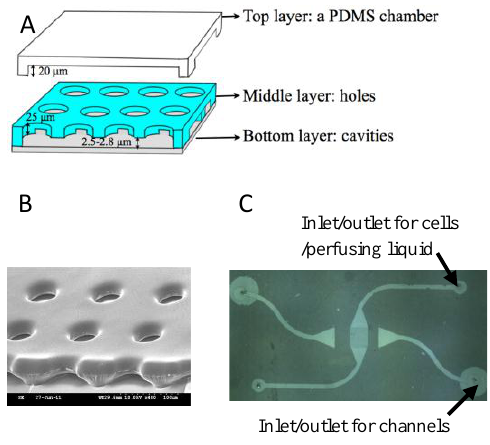
Figure 1 Schematic of the micro plug-hole like device. (A) a cross section (B) SEM image of the micro plug-hole like device (C) an overview